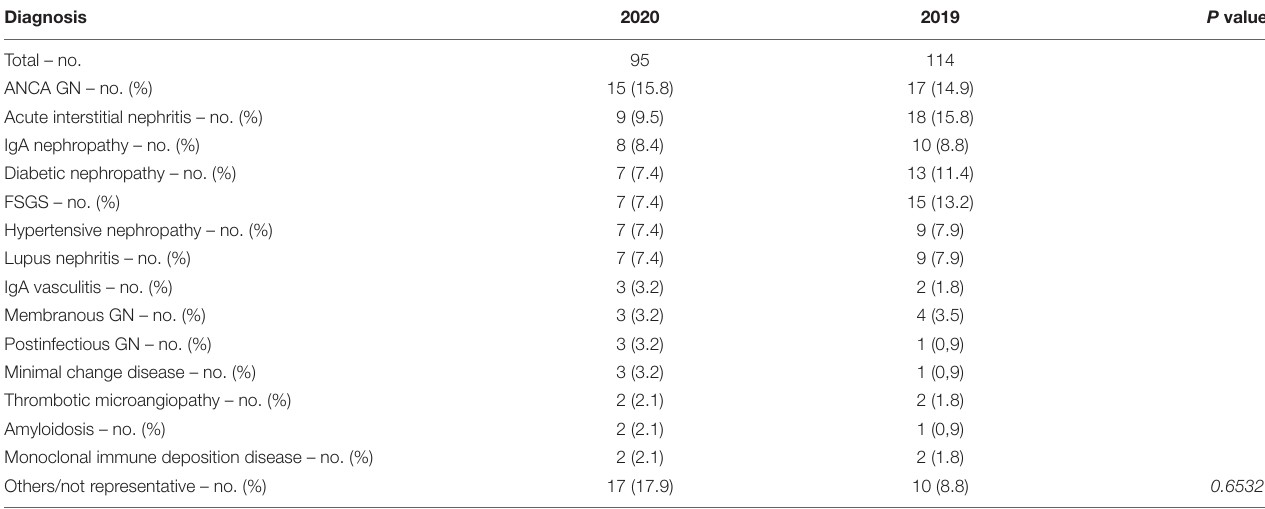
TABLE 1 | Diagnoses of kidney diseases based on renal biopsies comparing 2020 with 2019. Diagnosis